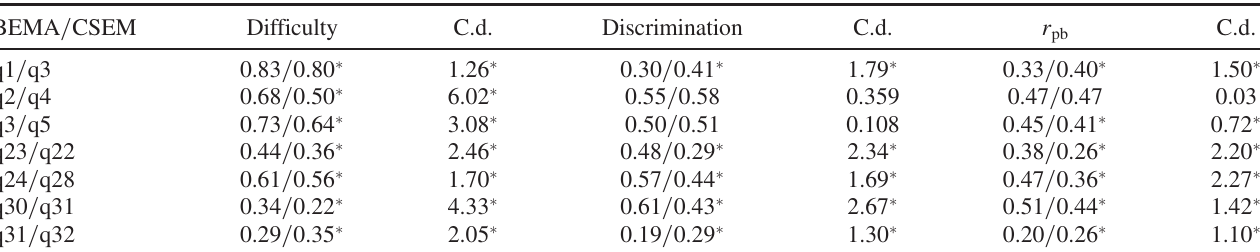
TABLE II. Comparison between classical difficulties, discriminations, and point biserials for the questions on the BEMA and CSEM that are the same. The numbers to the left of the “ = ” are for the BEMA and to the right are for the CSEM. The entries marked with a (cid:4) were found to be statistically different. All other entries were found to not be statistically different with p values < 0 . 001 . C.d stands for the absolute value of Cohen ’ s d .